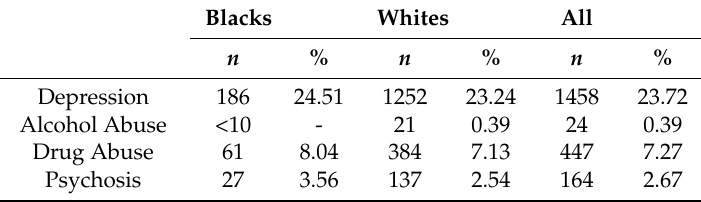
Table 3. Psychiatric disorders among Blacks ( n = 759) and Whites ( n = 5388) with suicidal attempt.